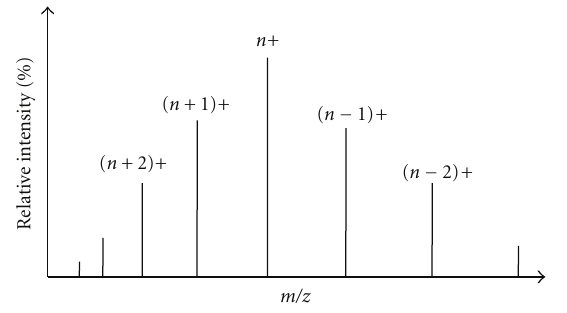
Figure 5: A typical cartoon representing the nature of ESI-mass spectrum in positive ion